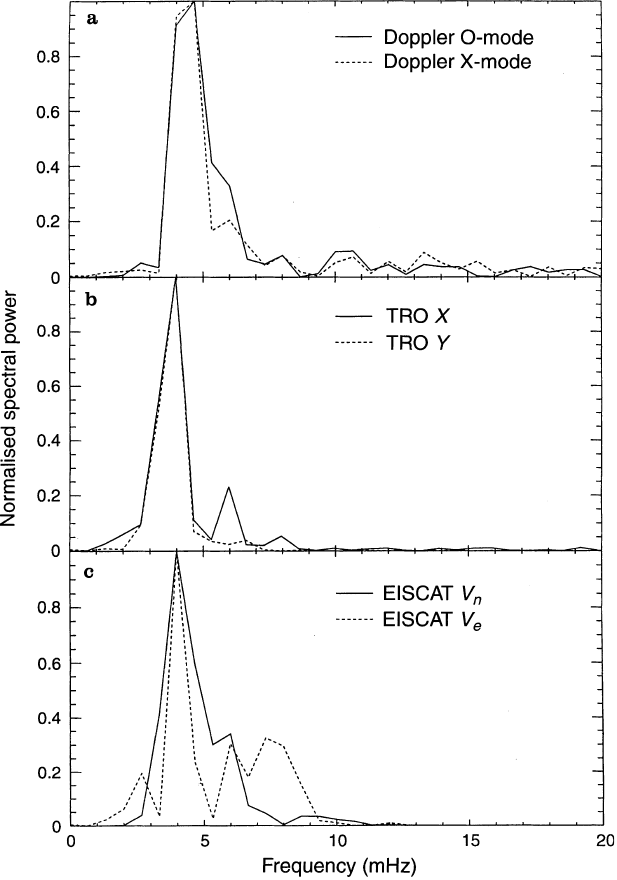
Fig. 4a–c. Normalised Fourier power spectra for each of the time- series in Fig. 3a–c for the interval